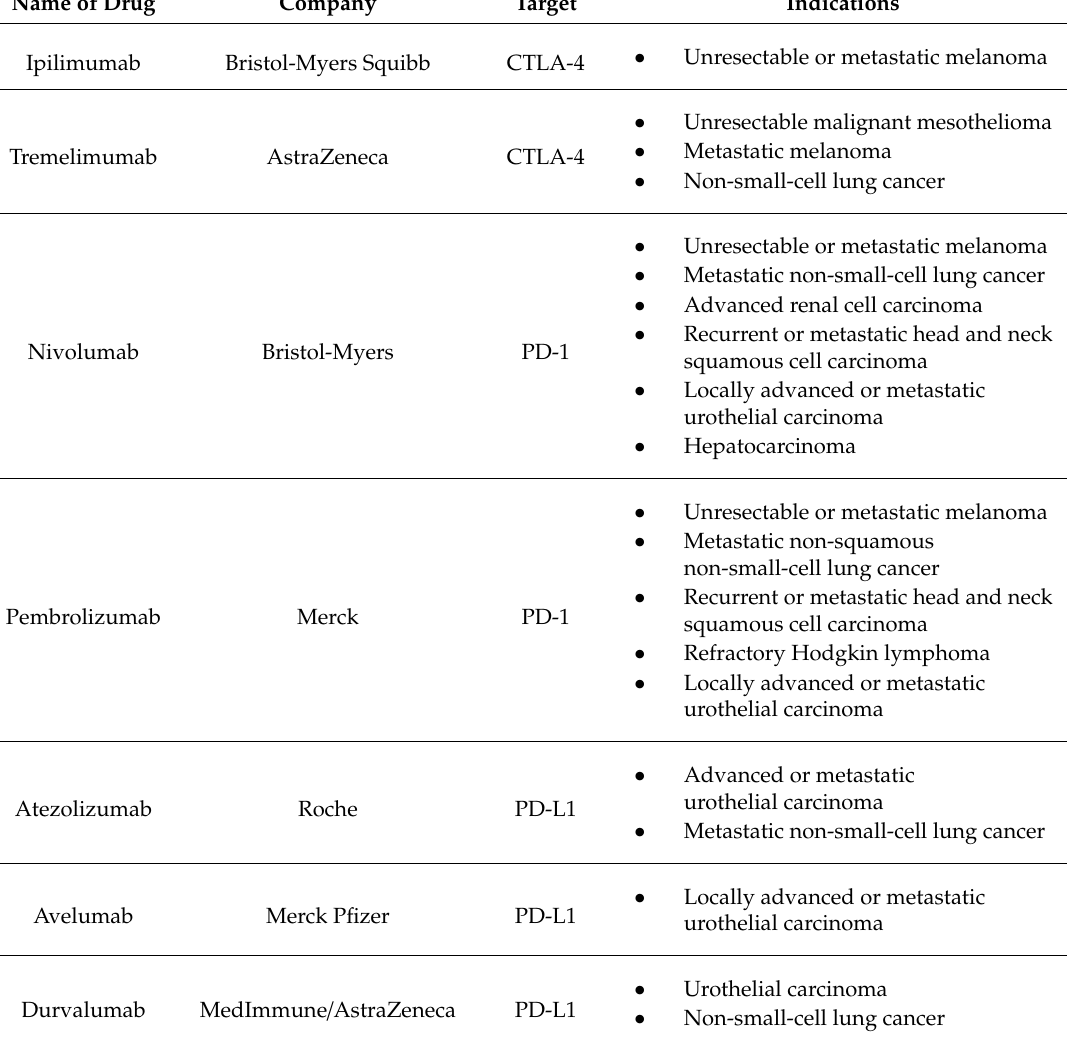
Table 4. FDA-approved checkpoint